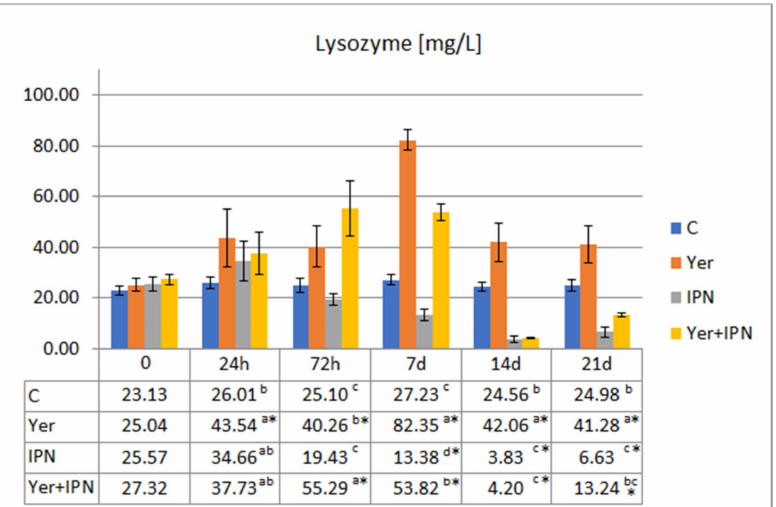
Figure 7. Mean values and standard deviation of lysozyme activity over the course of the first experimental infection. *—statistically significant differences compared to the day 0 values within a given group ( p ≤ 0.05); a, b, c, d —statistically significant differences between the groups on a given sampling day ( p ≤ 0.05).